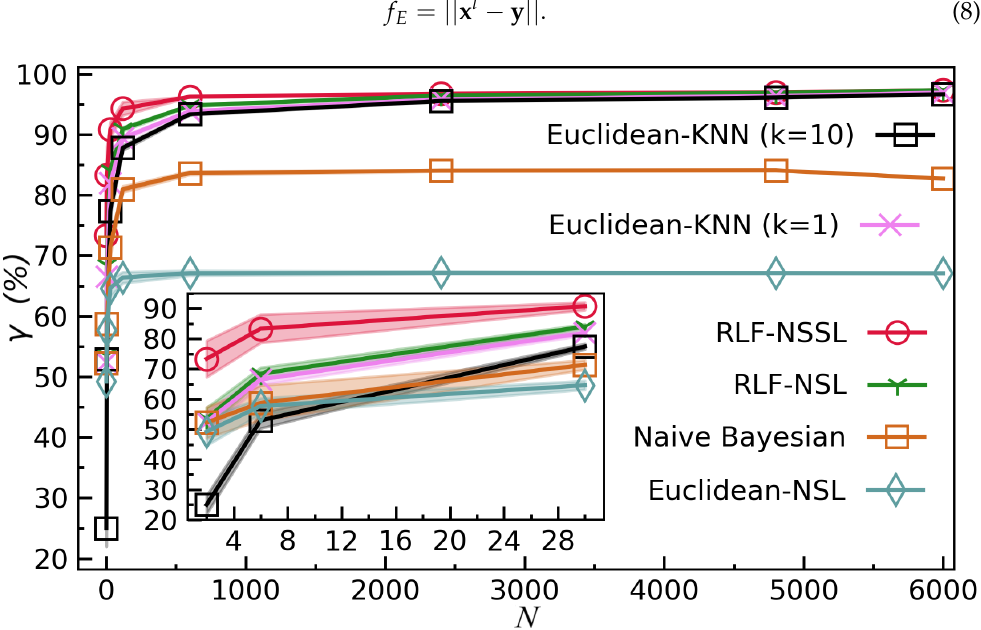
Figure 3. Testing accuracy γ of non-parametric semi-supervised and supervised learning using rescaled logarithmic fidelity (RLF-NSSL and RLF-NSL , respectively) on the MNIST dataset. Our results are compared with k -nearest neighbors with k = 1 and 10, naive Bayesian classifiers, and a baseline model by simply replacing RLF by the Euclidean distance. For more results of the KNN with different values of k and those of the p-norm distance with different values of p , please refer to the Appendix